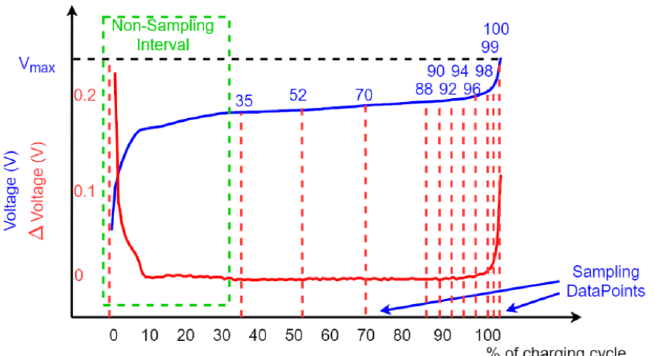
Figure 6. Sampling important values of current and voltage during a charge cycle.